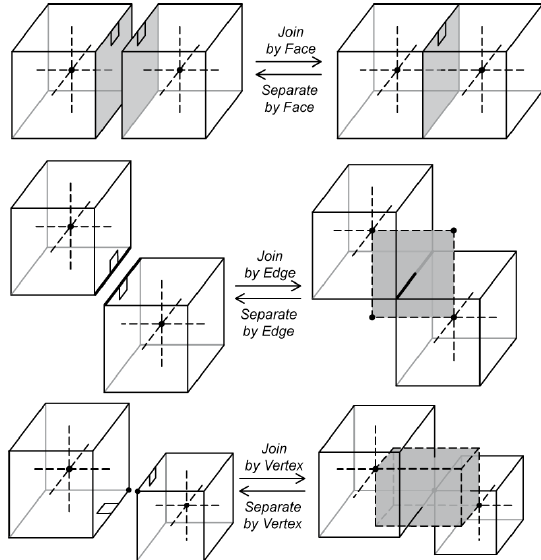
Figure 13. Join/Separate operators for cell complex construction.